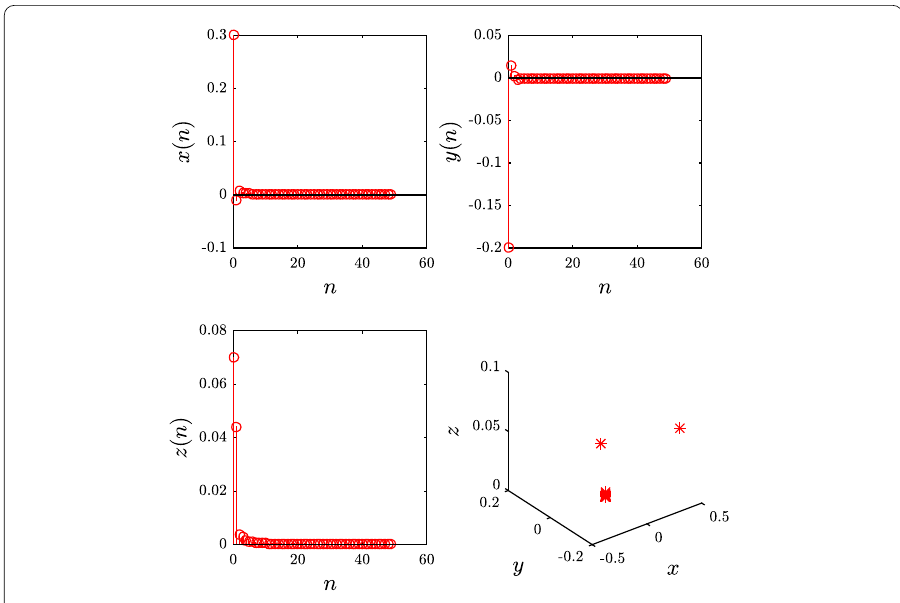
Figure 14 The time evolution of the controlled states for the fractional Rössler map